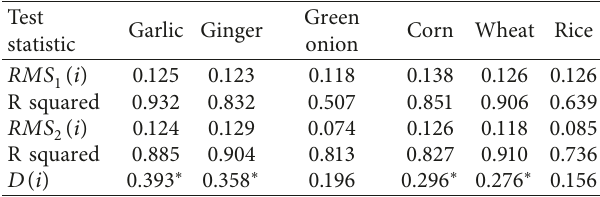
Table 3: The results of the evaluation of superexponential growth for the Chinese agricultural commodity